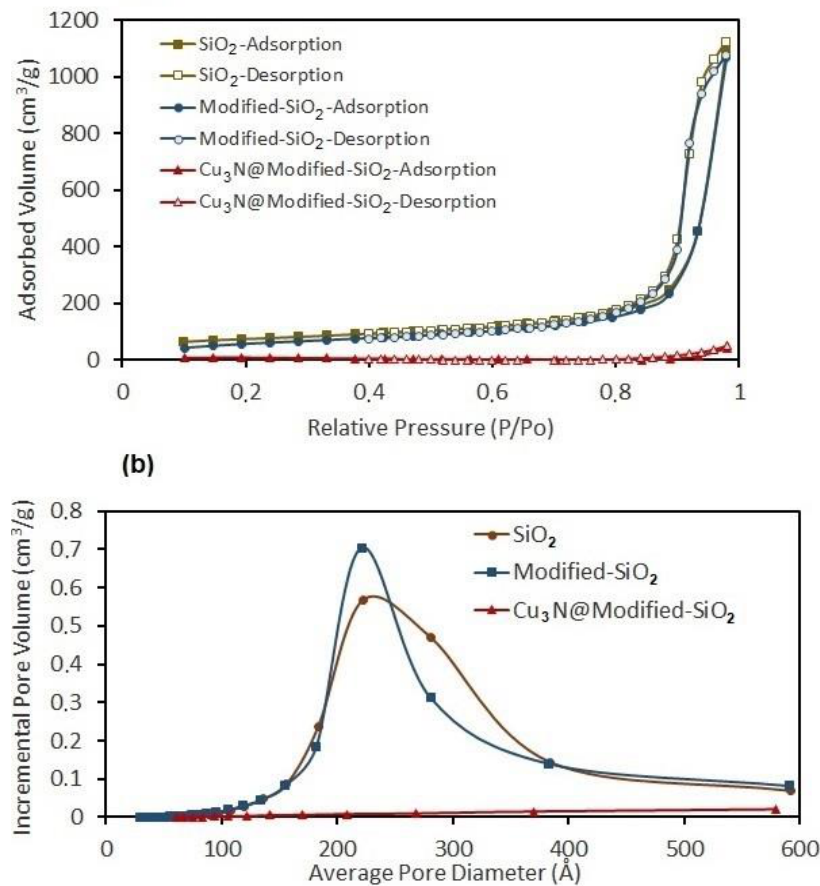
Figure 8. ( a ) BET isotherms and ( b ) the incremental pore volumes registered for the as-received SiO 2 aerogel, modified SiO 2 aerogel, and Cu 3 N/modified SiO 2 aerogel samples.